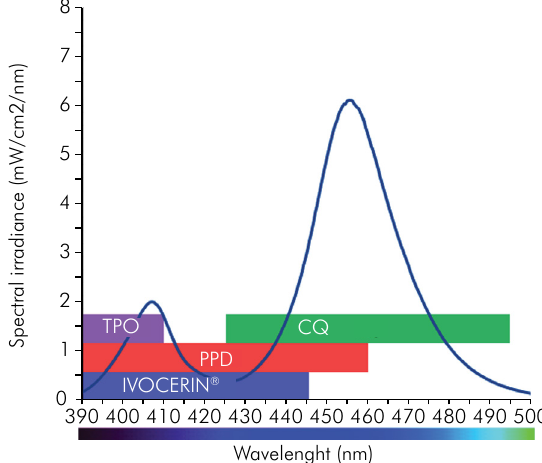
Figure 33. Spectral emission profile of a typical 3 rd generation dental LED curing light.